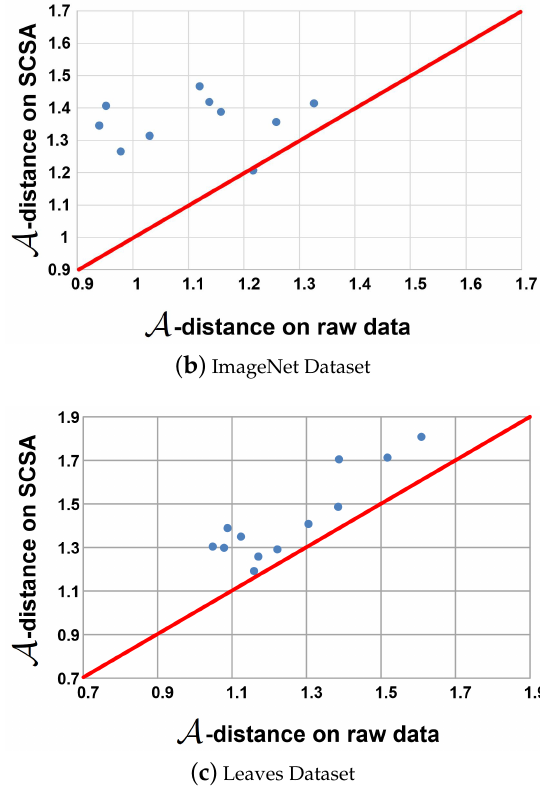
Figure 4. A -distance on Corel, ImageNet and Corel datasets. The x-axis and y-axis represent the A -distance on the raw data and learned features space.